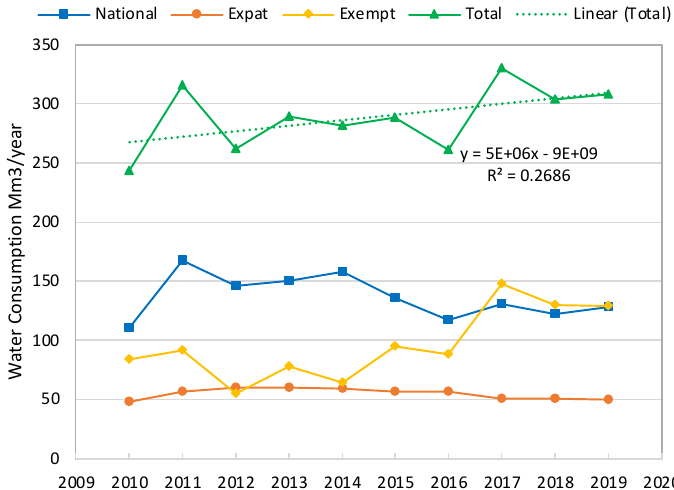
Figure 5. Residential water consumption by category (2010–2019).